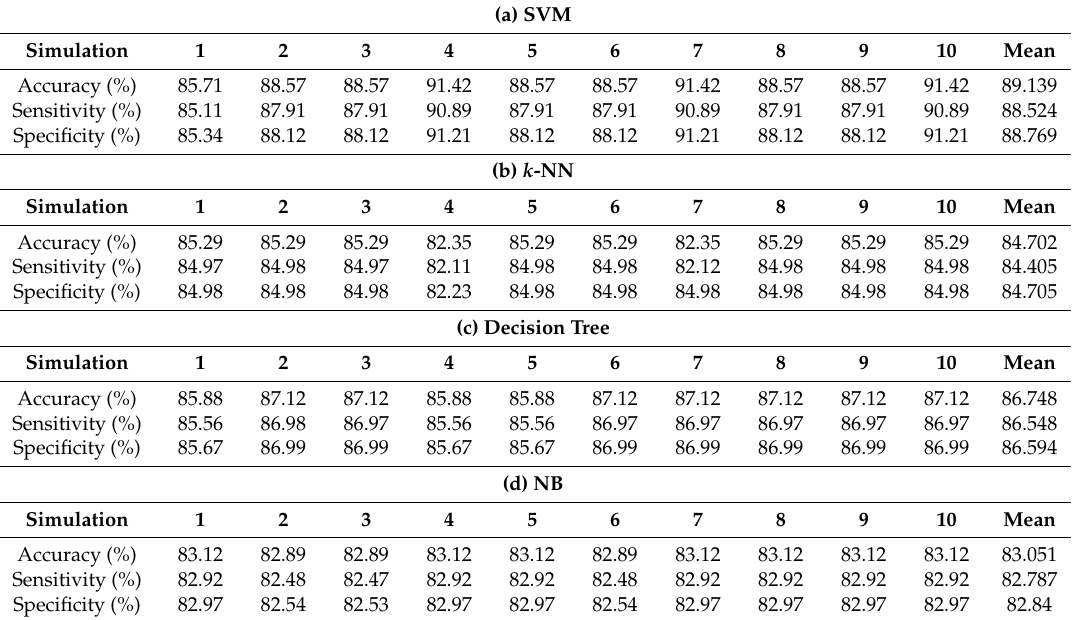
Table 3. Result of the four classifiers after 10 successive simulations.